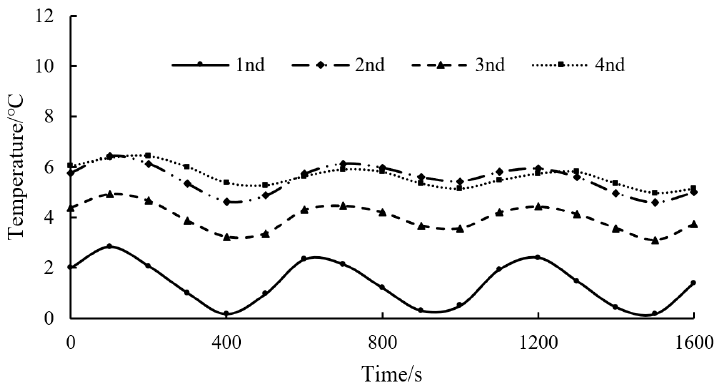
Figure 7. The effect of a 25% aperture ratio on the temperature of each layer in the cabinet.